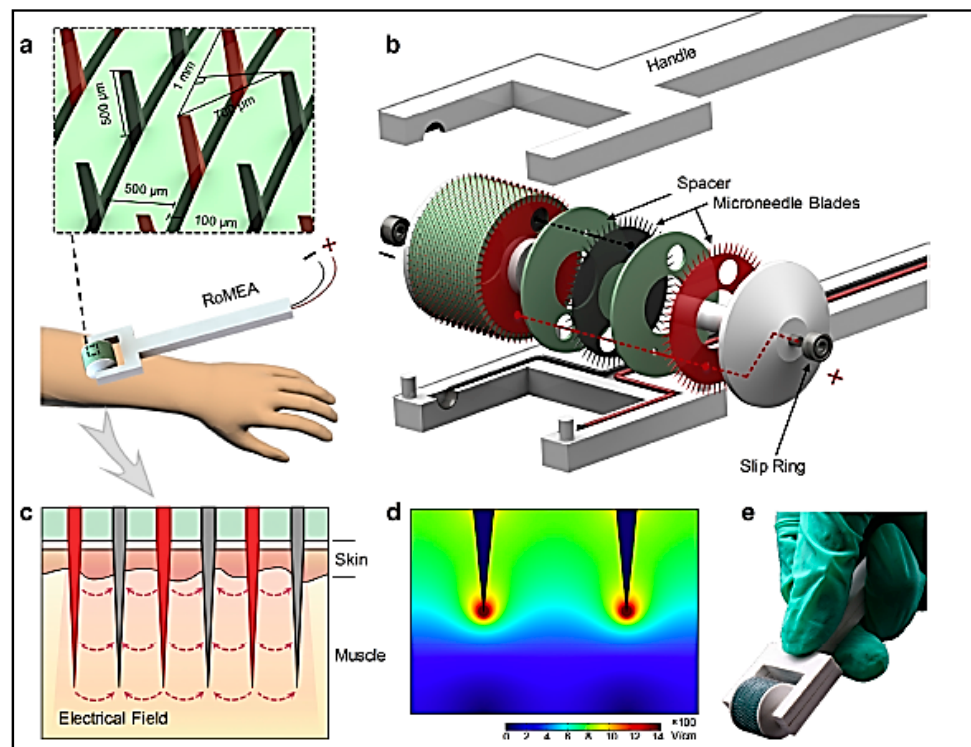
Figure 5. Schematic description of the mechanism of rolling microelectrode array (RoMEA) ( a ) RoMEA’s minimally invasive method of continuous electroporation in a vast region of the target tissue by rolling on the appropriate place. ( b ) Overall design of RoMEA device. Anode (red) and cathode (black) are connected by two nearby microneedle blades. ( c ) Microneedle electroporation. ( d ) Stimulation of RoMEA by electric field (50 V). ( e ) The RoMEA prototype [90]. Reproduced with permissions from Tongren Yeng et al., Nano Today , Elsevier,